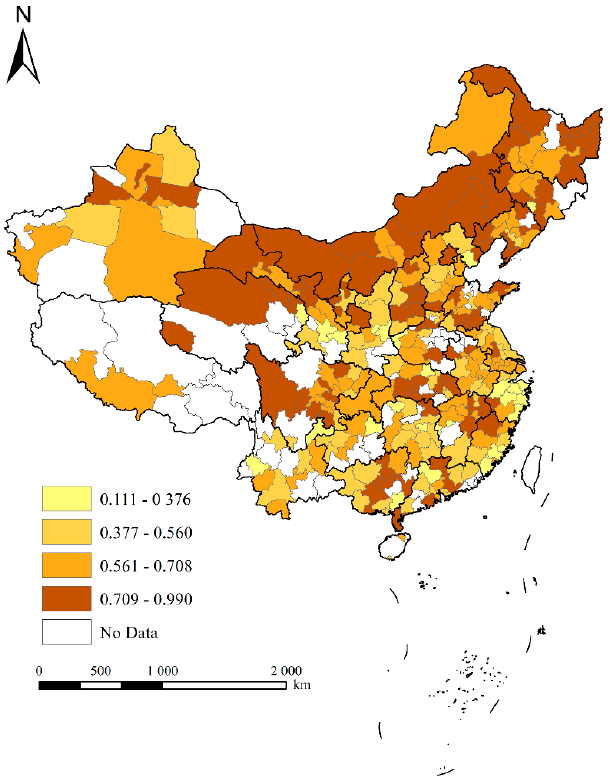
Figure 1. The spatial pattern of the settlement intention of the elderly people.